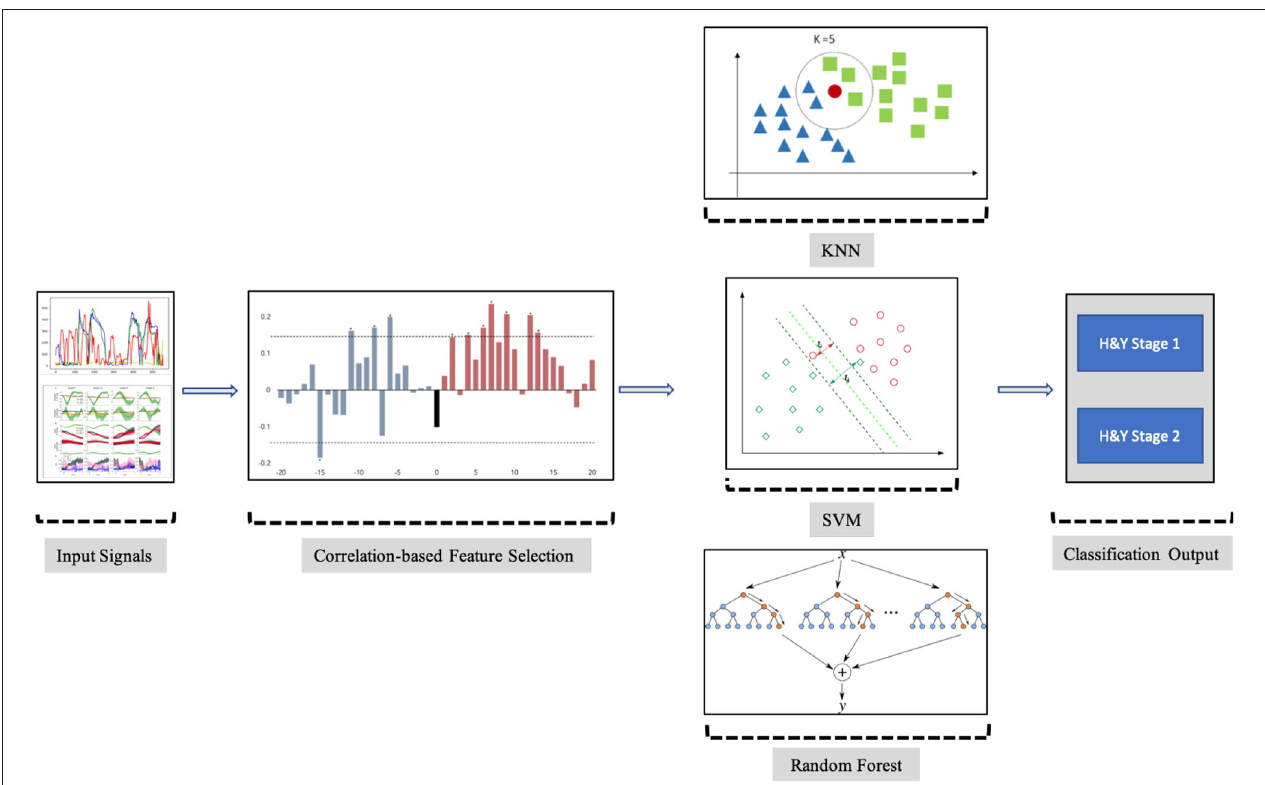
FIGURE 4 | Block diagram of the steps employed in the proposed